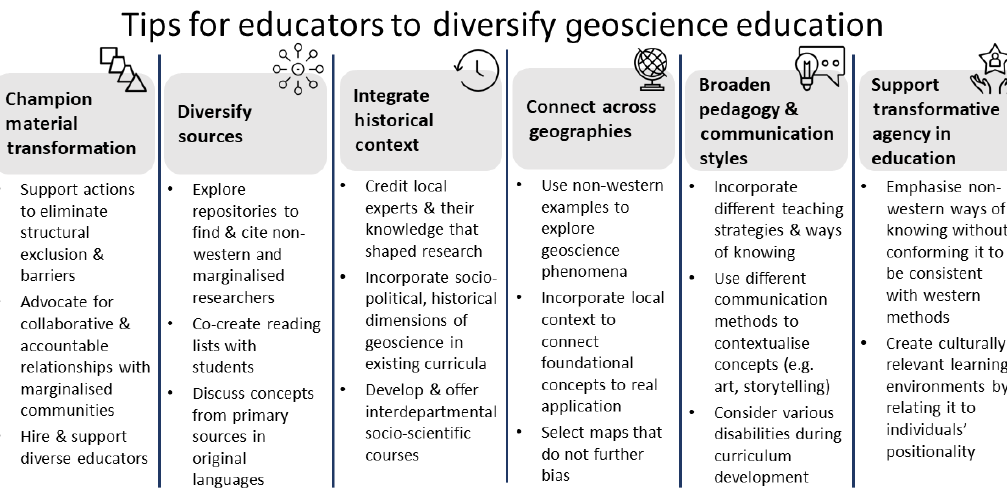
Figure 1. Summarised recommendations for educators to diversify their geoscience curricula and